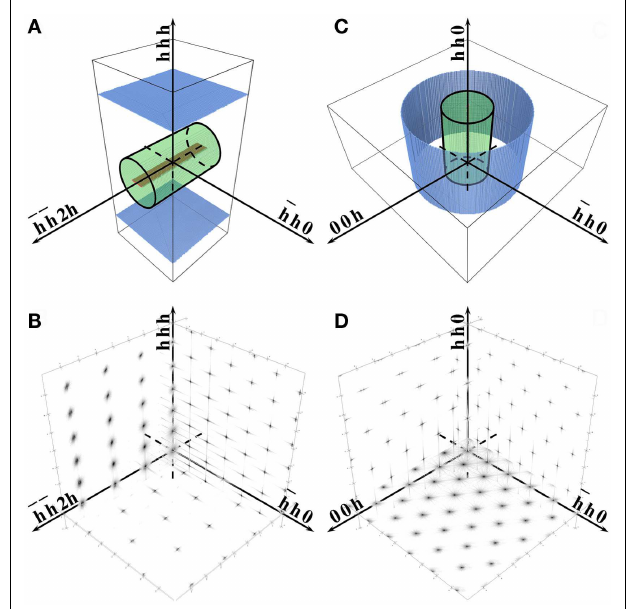
FIGURE 1 | Schematic description of cylindrical nanocrystals with edge (A) and screw (C) dislocations embedded in corresponding parallelepiped volumes treated by Molecular Dynamics [30 × 30 × 46nm for (A) and 40 × 40 × 28.7nm for (B)] . Surfaces in color are left free during MD equilibration, whereas PBCs are applied to the other surfaces: (cid:104) (cid:105) (cid:104) (cid:105) along hh 2 h and hh 0 in (A) , and along [ hh 0] in (C) . Corresponding reciprocal space cross-sections of diffracted intensity are shown below: (B) for cylinder in (A) , and (D) for cylinder in (C) .